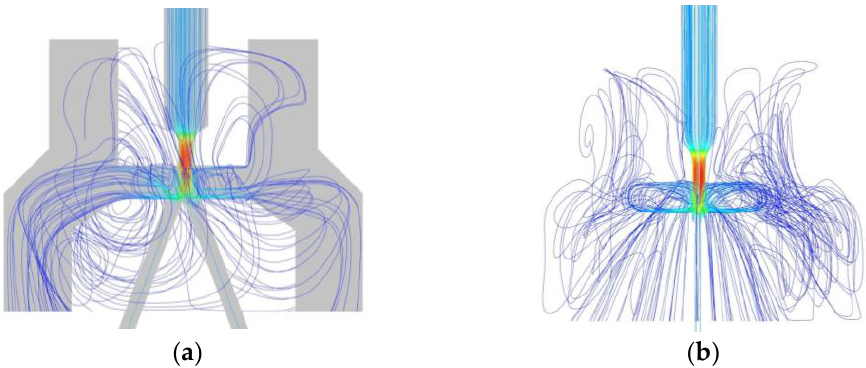
Figure 11. Streamline distribution diagram of jet tube migration. ( a ) Z projection; ( b ) X projection.